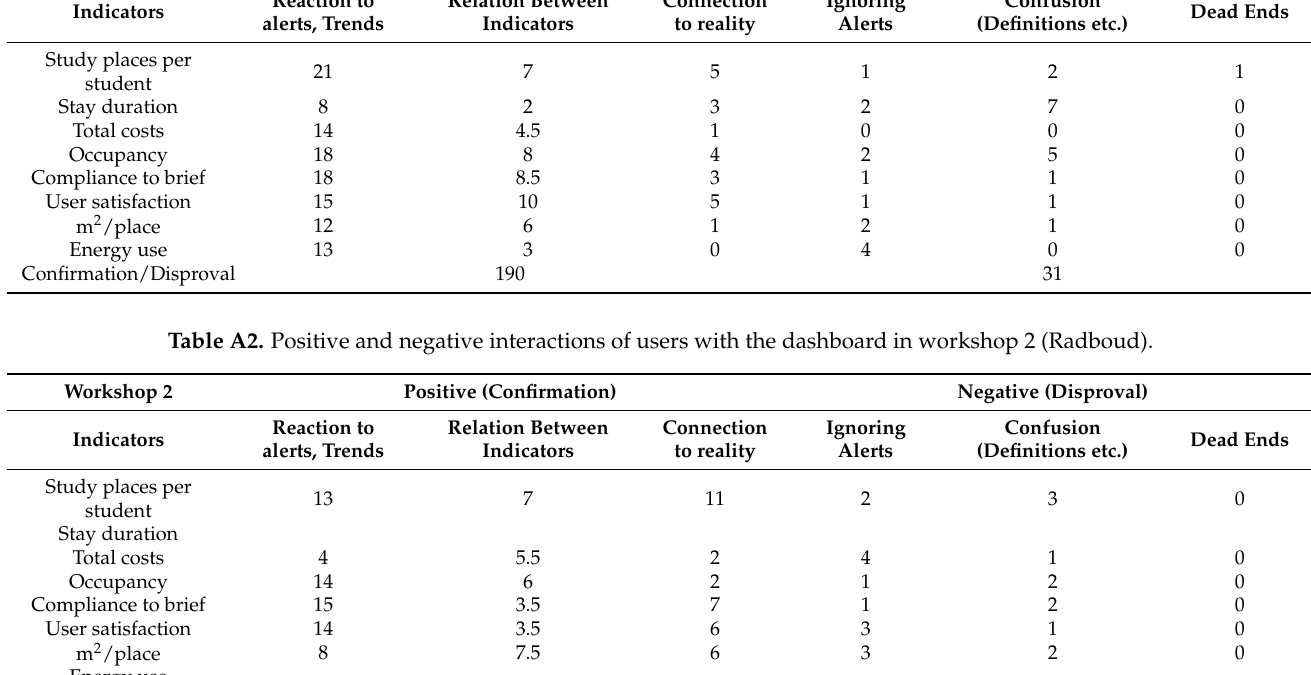
Figure A4. Overview of buildings TU Delft (workshop 2). The dashboard shows the five buildings that require the most attention and to which aspects attention should be directed.